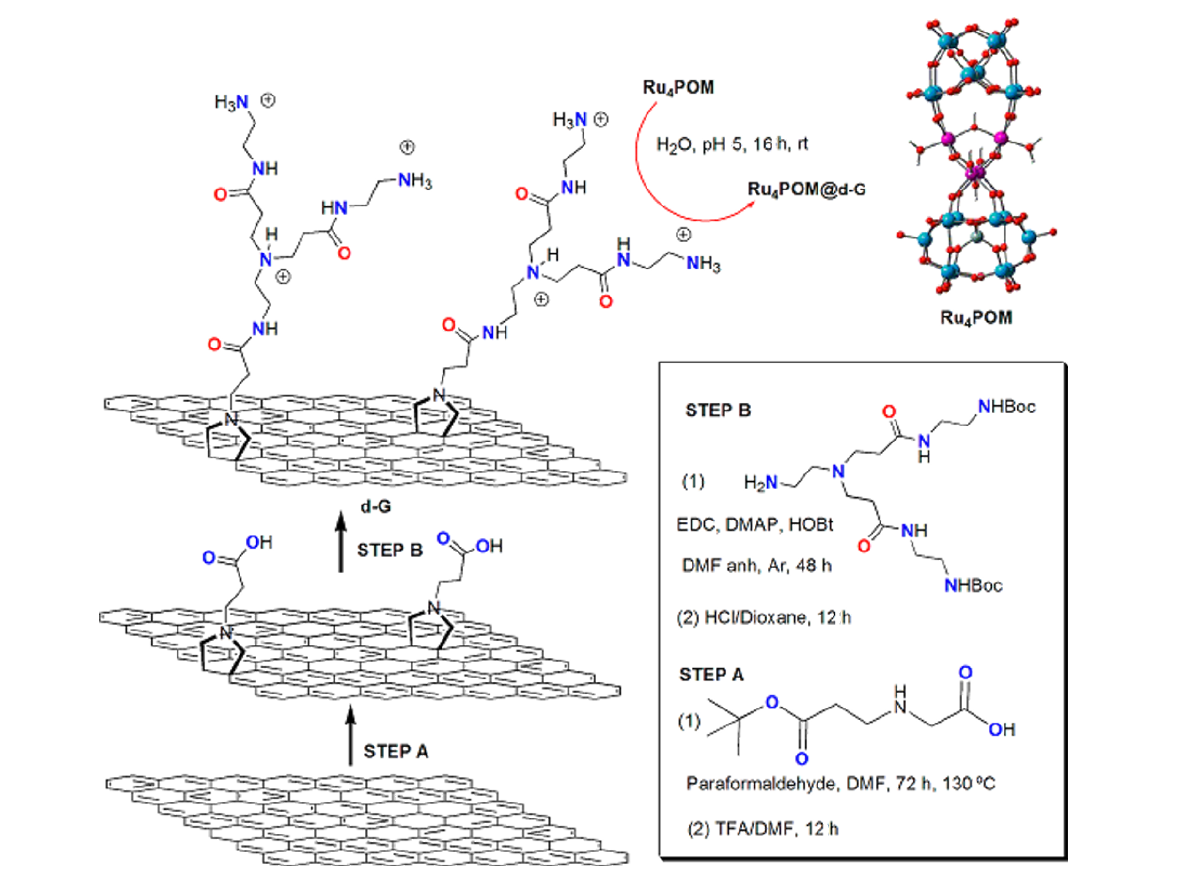
Figure 8: Synthesis of a graphene nano-platform supporting Ru 4 POM. Reproduced with permission from [43], copyright 2013 American Chemical Society.